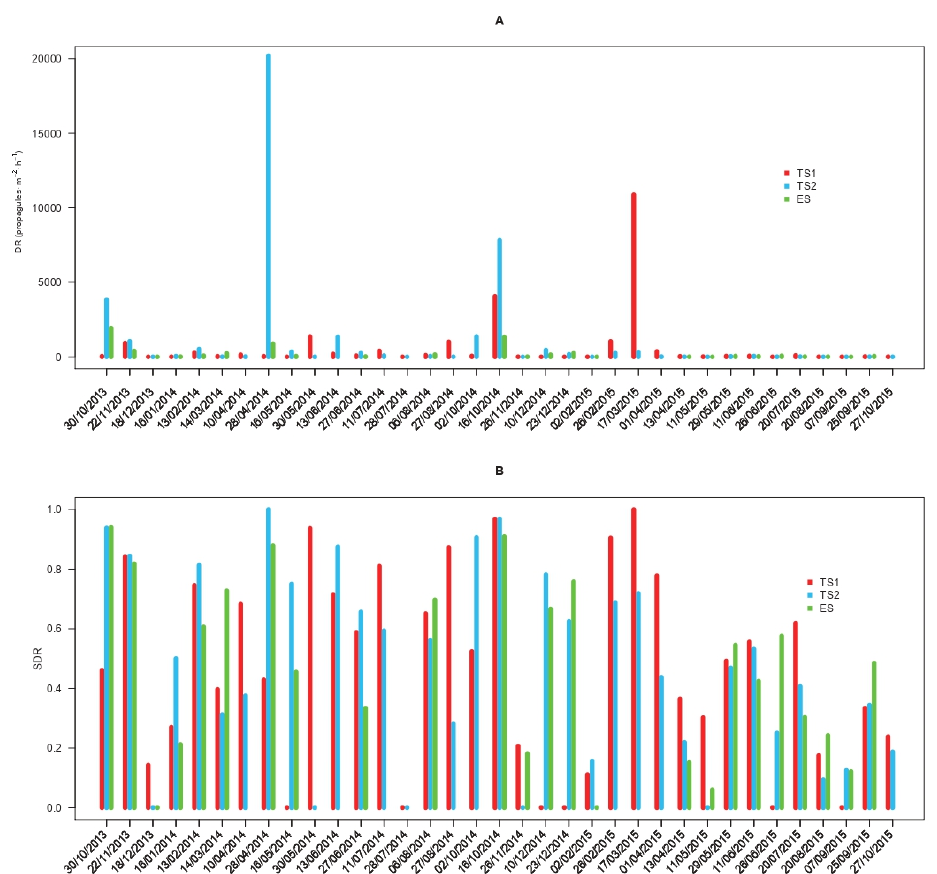
Figure 1. Time series of the propagule deposition pattern of Cryphonectria parasitica . The average propagule deposition rate (DR) is reported in propagules·m − 2 ·h − 1 (panel A ), and the corresponding standardized deposition rate (SDR, Panel B ) is shown. Deposition rates are displayed for